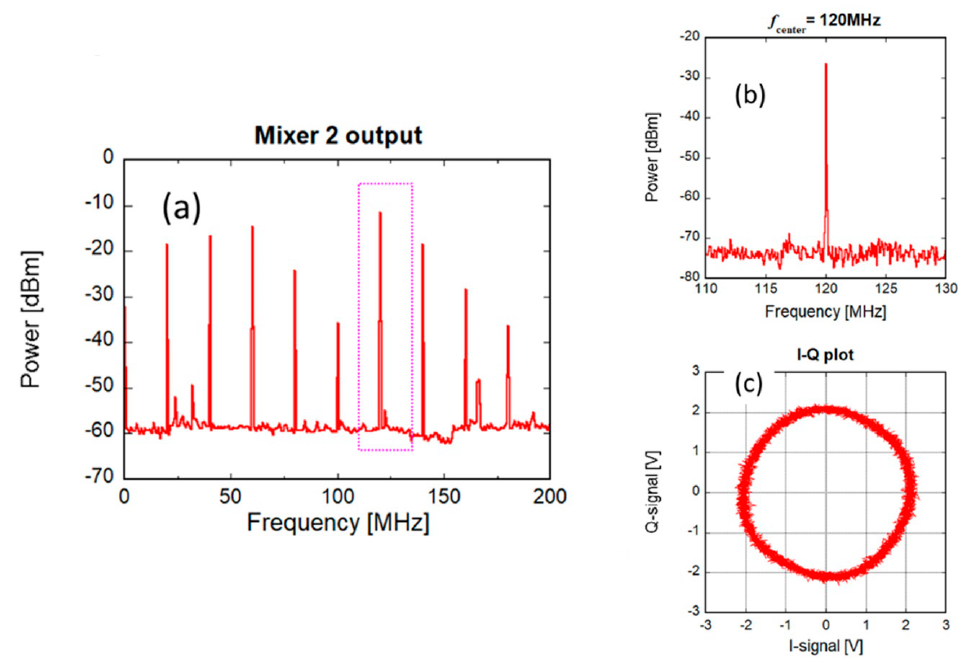
Figure 8. Frequency spectra of reference signal of IQ detection circuit (monitor point 5). ( a ) Entire reference signal and ( b ) 120 MHz component of a portion of the figure in ( a ) (the area enclosed by the dotted square) enlarged. ( c ) Example of phasor plot (In- phase and Quadrature-phase).